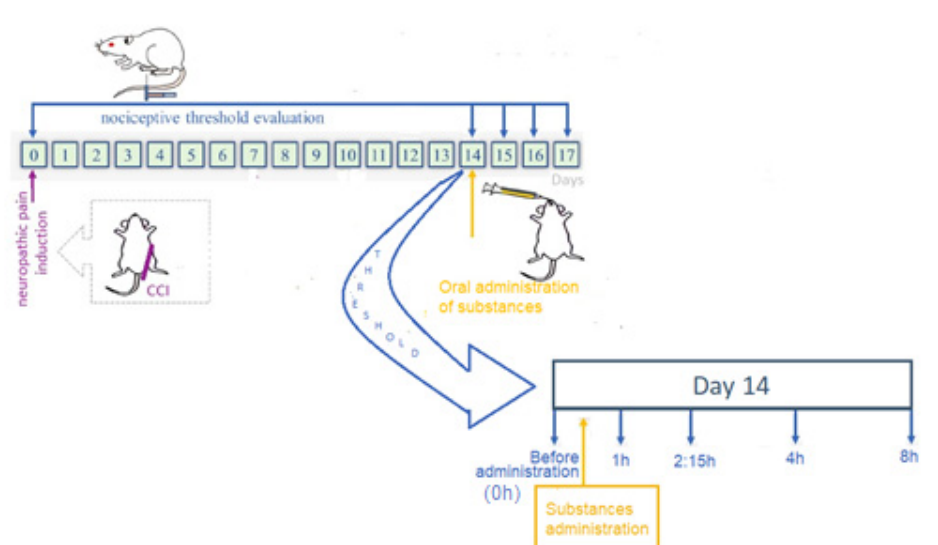
Figure 1. The experimental design was adopted to evaluate pregabalin delivery systems based on polyelectrolyte nanocomposites in comparison to the free drug for oral treatment of neuropathic pain. CCI—chronic constriction injury.